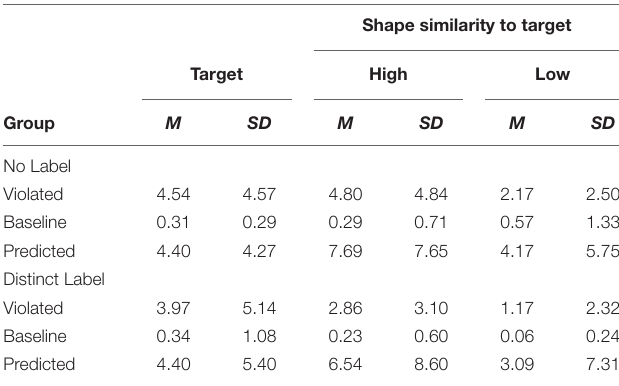
TABLE 4 | Frequency of target actions performed on the test objects at each level of shape similarity within each expectation